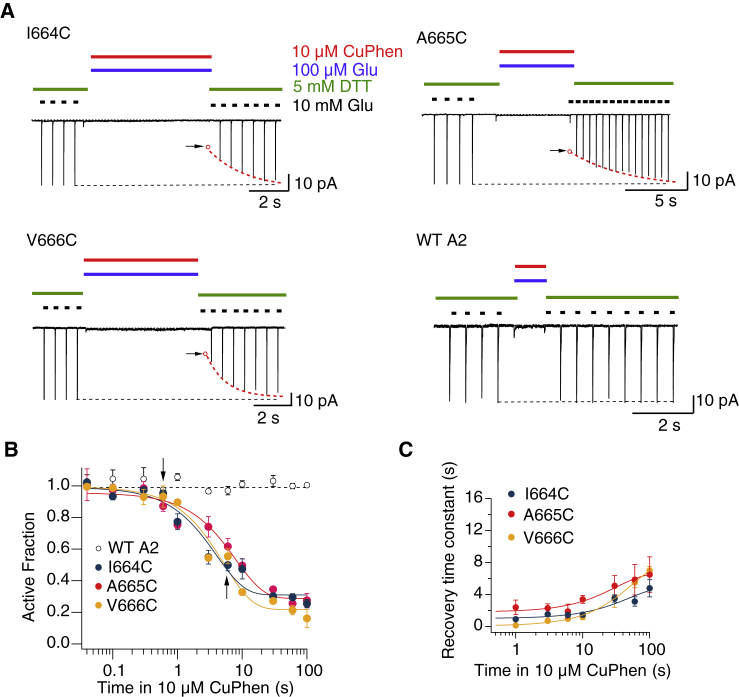
Contact between subunits A and C during desensitization. (A) Typical patch-clamp experiments for cysteine mutations at positions 664–666 and WT GluA2. Dotted red line is the exponential fit to recovery of the current in 10 mM glutamate and DTT, following trapping in the presence of 10 μM Cu:Phen and 100 μM glutamate. Open circles with an arrow indicate the presumptive back-extrapolated response immediately after trapping. (B) The AF of receptors after oxidization in the desensitized state plotted against the trapping interval (continuous lines are exponential fits). The probabilities of no difference in the AF after 10-s trapping in 10 μM Cu:Phen were 0.001, 0.0005, and 0.00003 for I664C, A665C, and V666C, respectively (compared to WT A2, Student’s t-test, n = 3–4 patches per point). The arrows indicate the relevant intervals for the traces in (A). (C) The time constant of recovery after trapping is plotted against the trapping interval for I664C, A665C, and V666C, showing a positive correlation (continuous lines are exponential fits; n = 3–4 patches per point). To see this figure in color, go online.